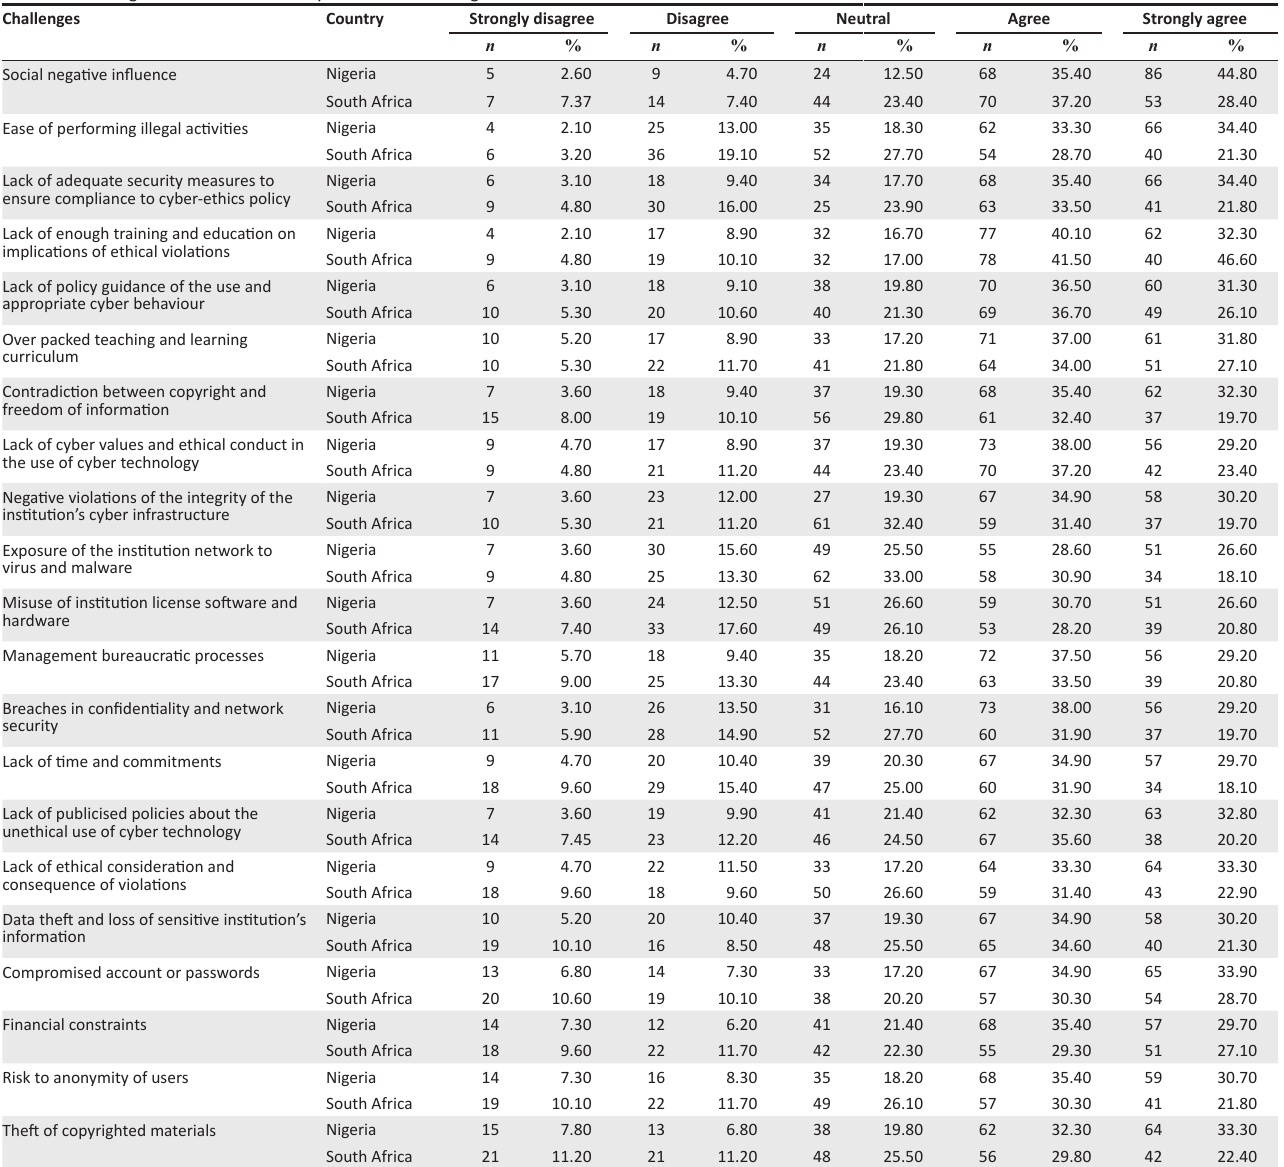
TABLE 3: Challenges to students’ ethical cyber behaviour in Nigeria and South